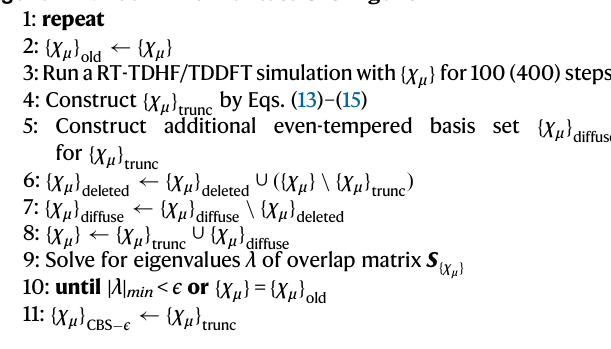
Fig. 1 | Schematic diagram of the basis set truncation process. First, a real-time propagation run of 1% (e.g., 100 steps) of the total simulation time is performed. Then the information of AO density matrix P AO ( t ) and MO coef fi cient C ( t ) at every step,andoverlapmatrix S ,iscollected.Basisfunctionstobetruncatedareselected